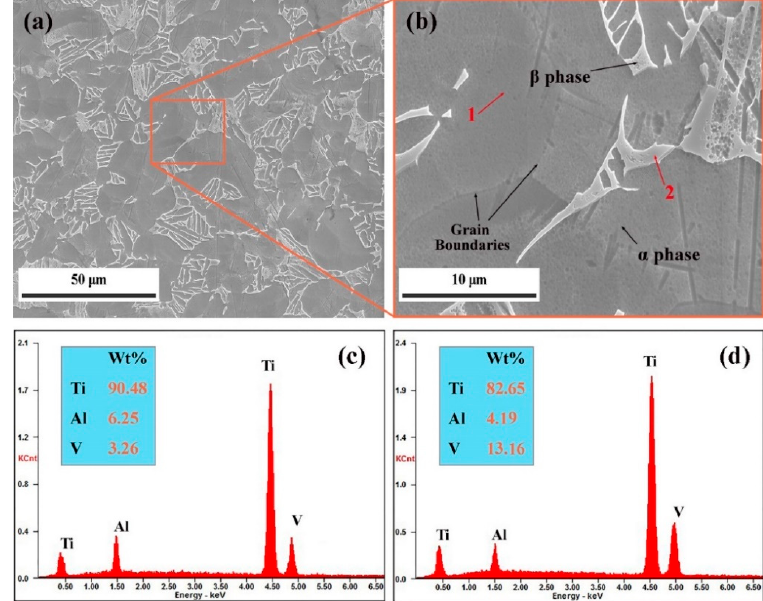
Figure 1. ( a , b ) The Scanning Electron Microscope (SEM) micrographs of the alloy Ti-6Al-4V, and the